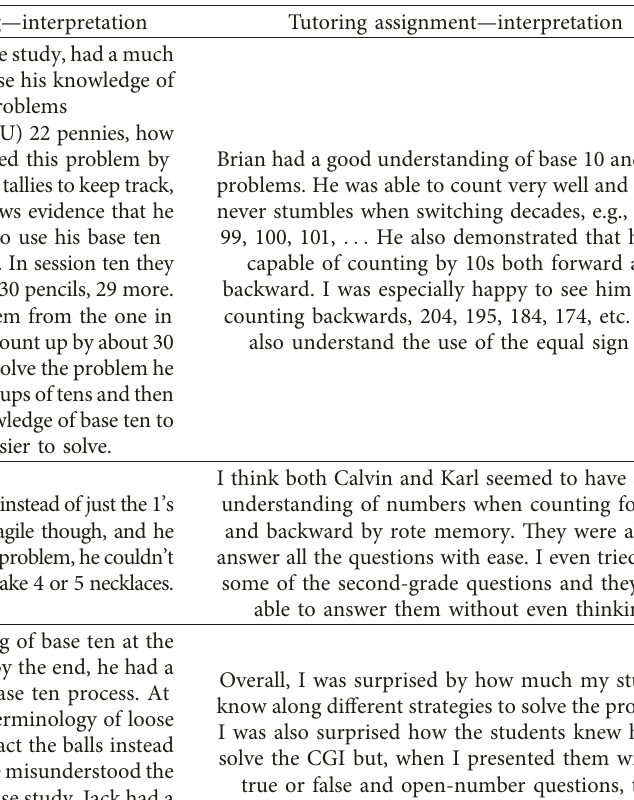
Table 3: Examples of responses coded as robust, limited, and lack of